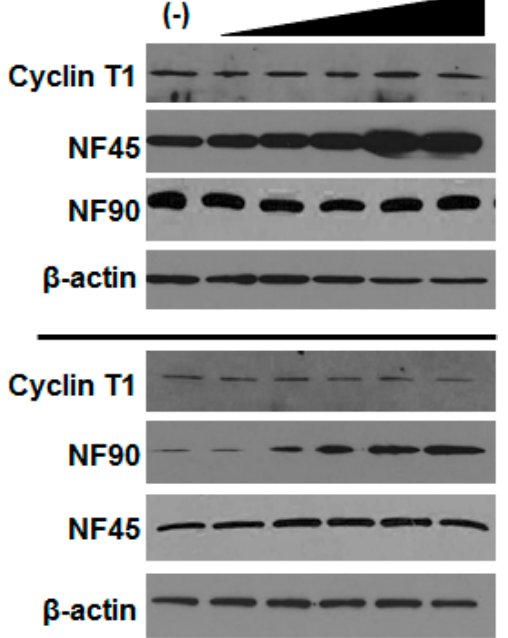
Figure 5. Cyclin T1 expression in cells over-expressing NF45 and NF90. 293T cells were transfected with increasing amounts of NF45 (top panels) and NF90 (middle panels). After 24 h, cells were harvested, normalized for protein concentration, and immunoblotted for indicated factors. Data are representative of duplicate experiments.